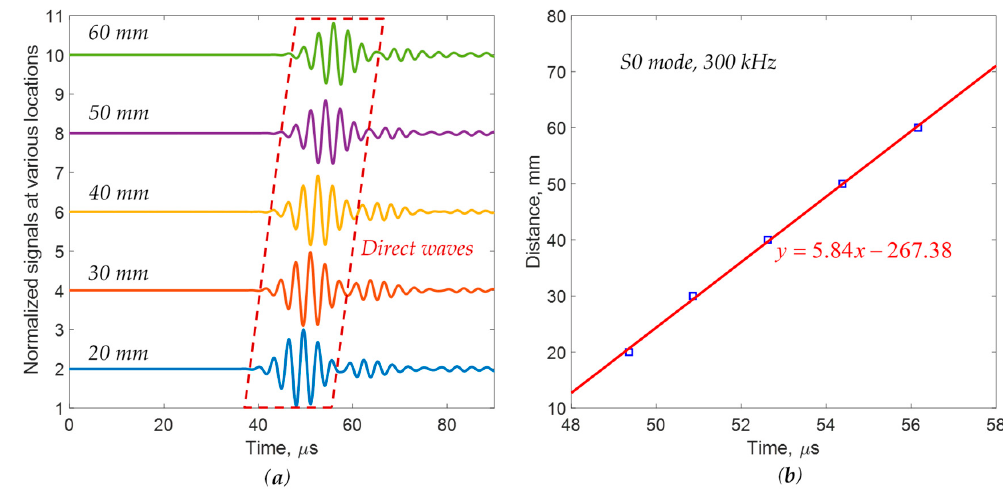
Figure 18. Experimental group velocity measurements for the S0 mode excitation at 300 kHz on a 3-mm quasi-isotropic composite plate: ( a ) waveforms; ( b ) correlation between distance and time of flight (TOF).